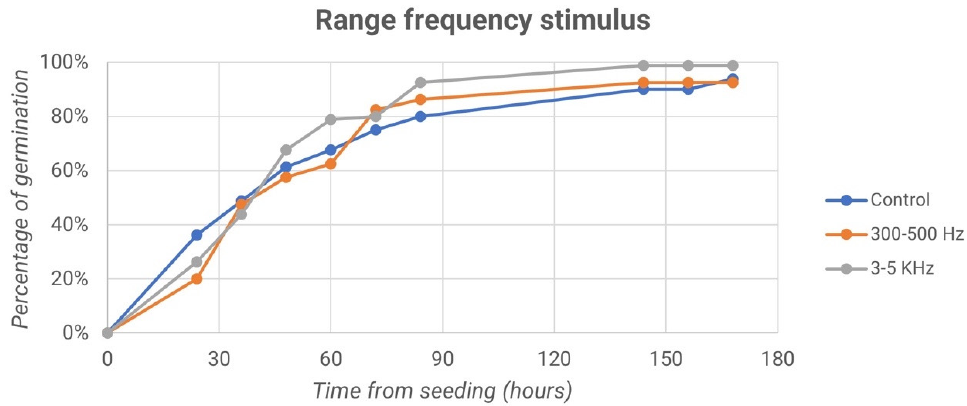
Figure 13. Percentage of germination vs. time from seeding for both the control samples and the samples treated with frequencies of 300–500 Hz and 3–5 kHz: third experiment.